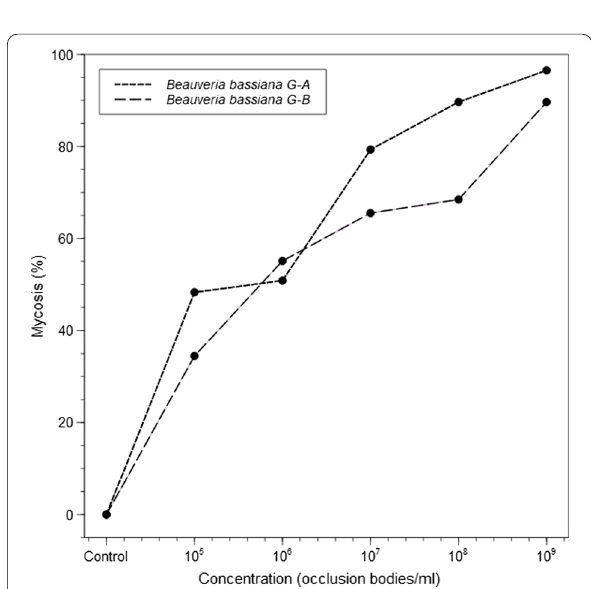
Fig. 4 Galleria mellonella larvae mycosis after the administration of five spore concentration of G-A and G-B Beauveria bassiana isolates